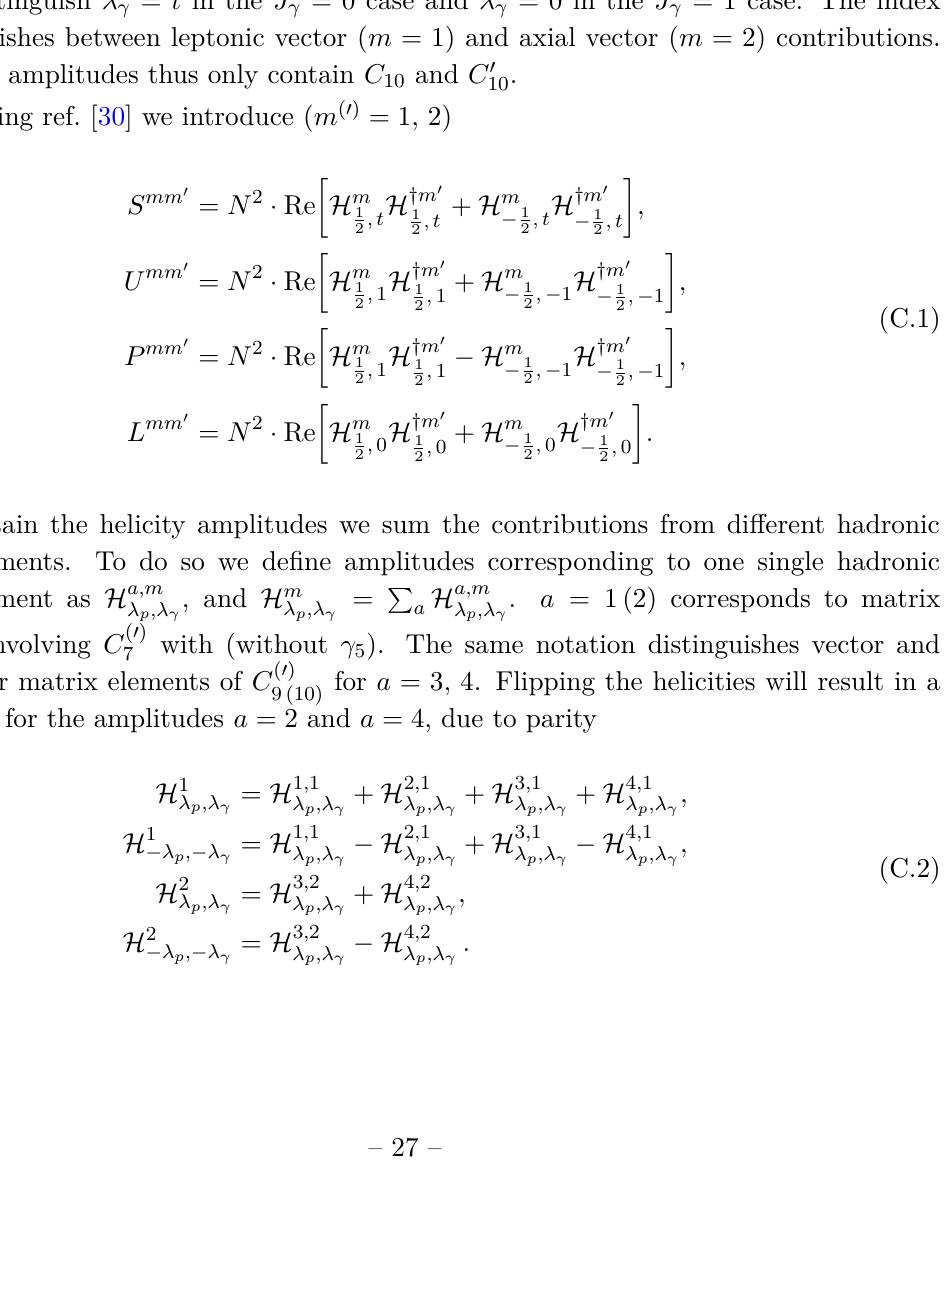
, whereas λ takes values of 0 , ± 1 and we γ 2 = 0 case and λ = 0 in the J = 1 case. The γ γ γ